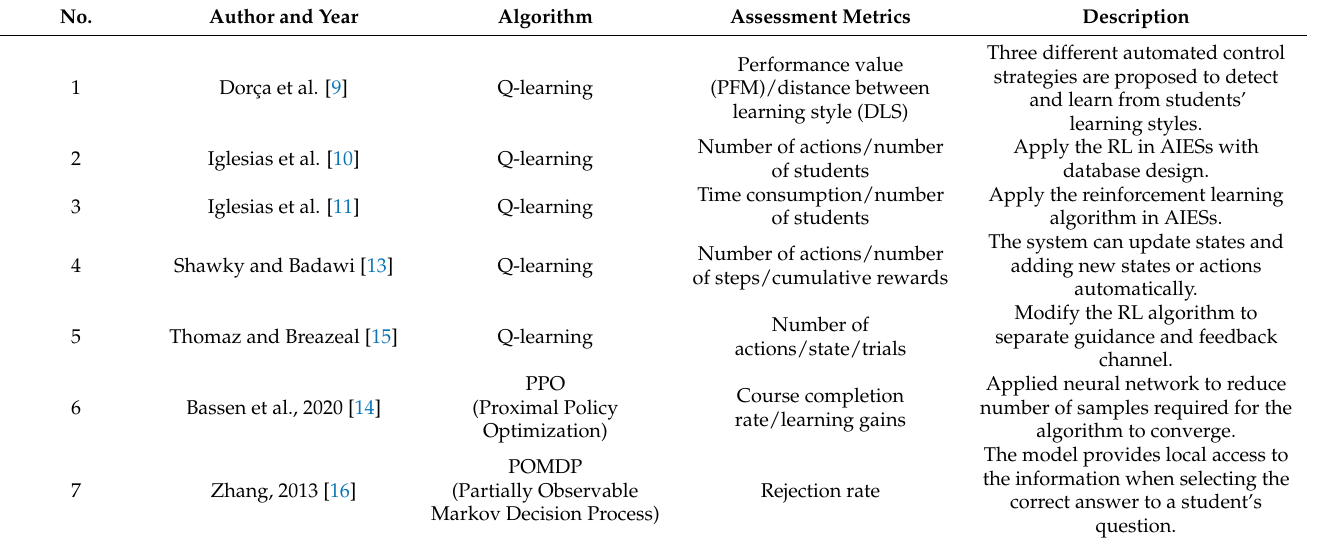
Table 3. Current research for intelligent tutoring